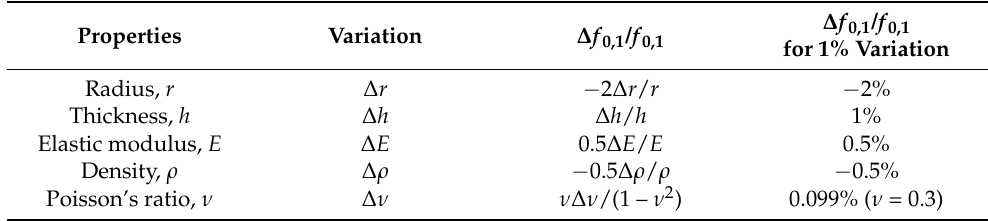
Table 3. Change in the natural frequency f 0,1 by the variation in the geometric and mechanical properties of the